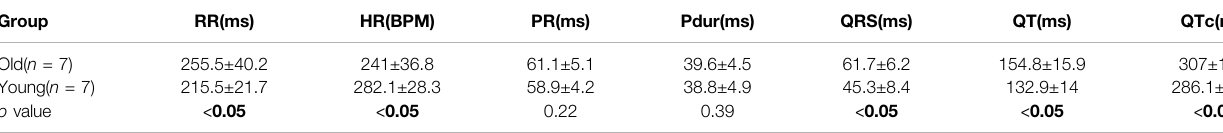
TABLE 5 | Age-dependent effects on ECG parameters using PES-AW approach. Group